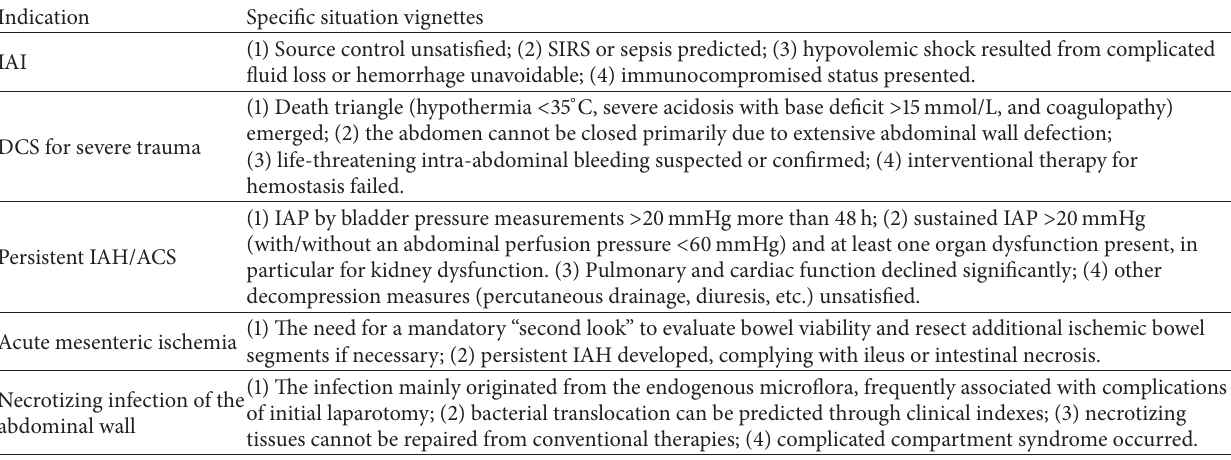
Table 1: The recognized indications for the open abdomen treatment.